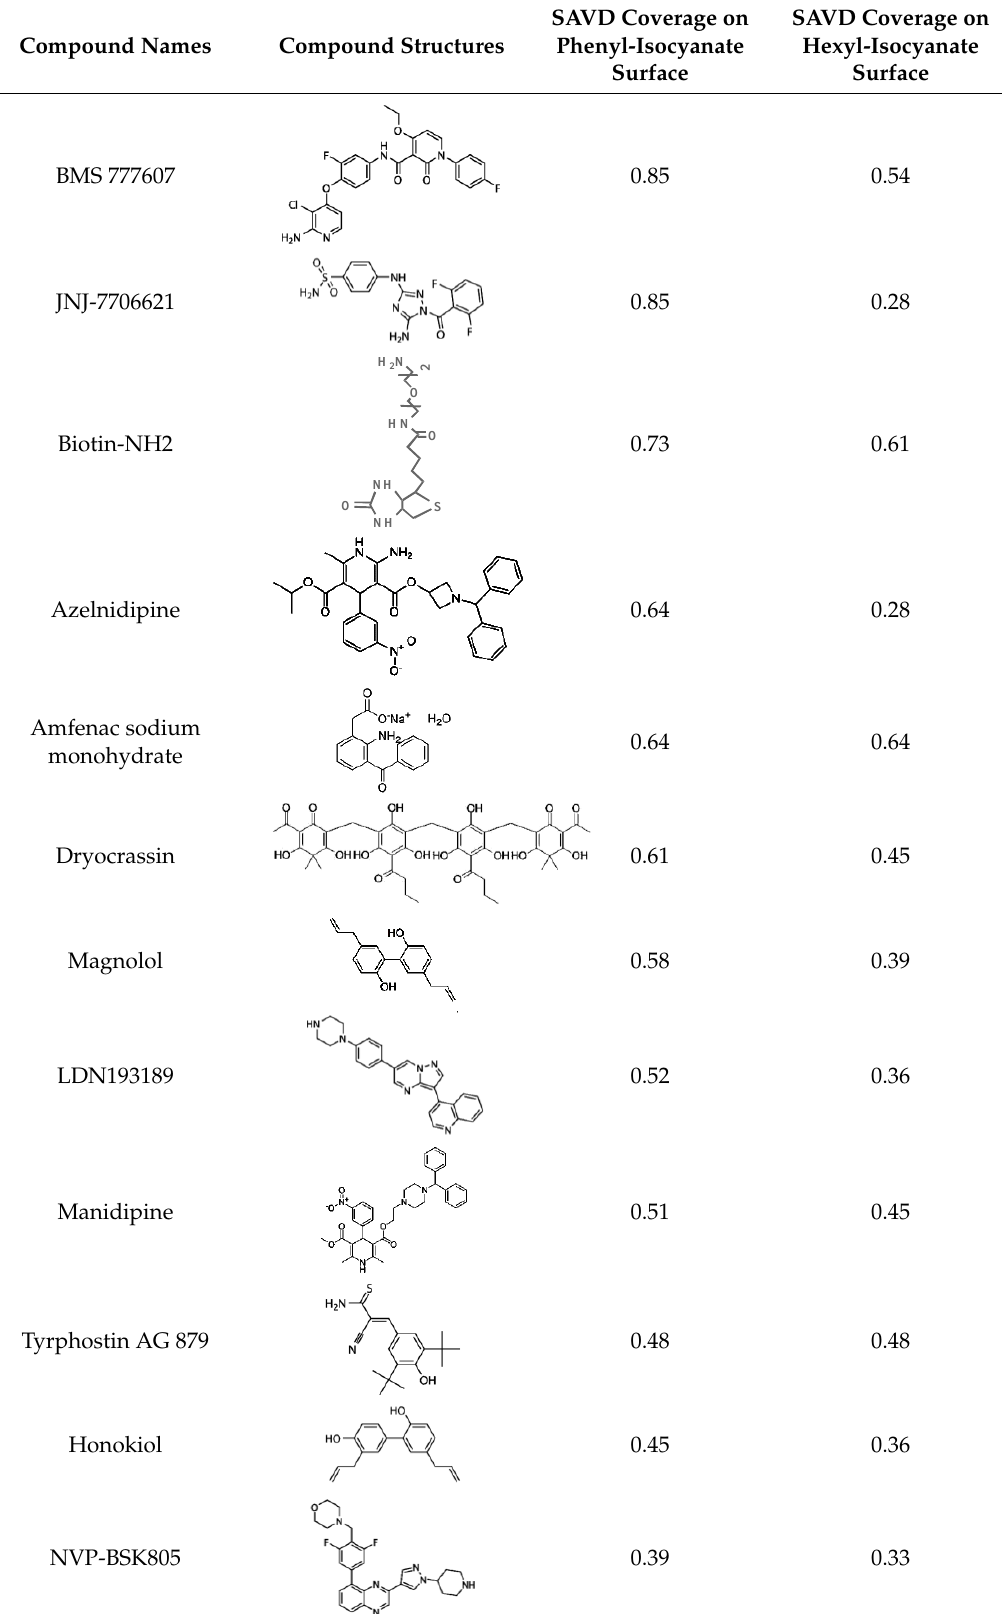
Table 2. Hit compounds and surface coverage of SAVD on both a phenyl-isocyanate surface and hexyl-isocyanate surface.